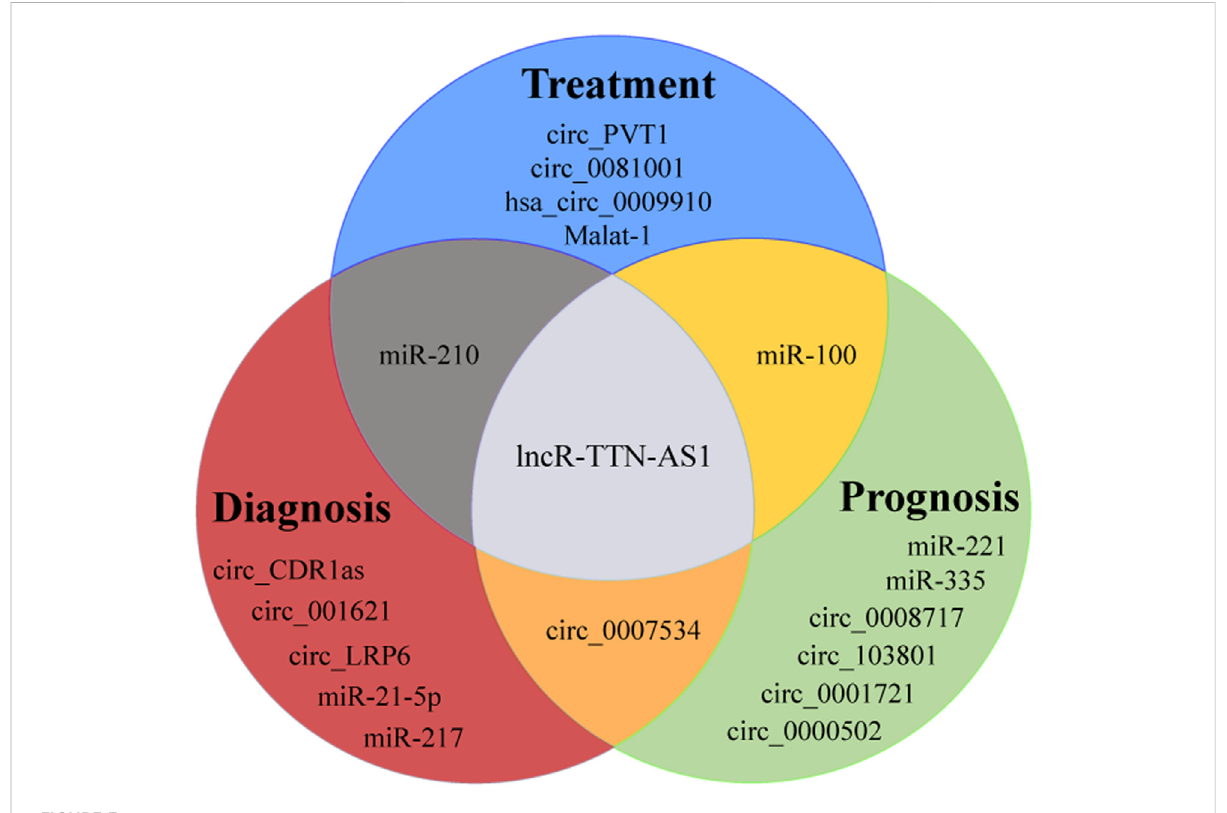
FIGURE 3 Crosstab of the roles of selected ncRNAs in